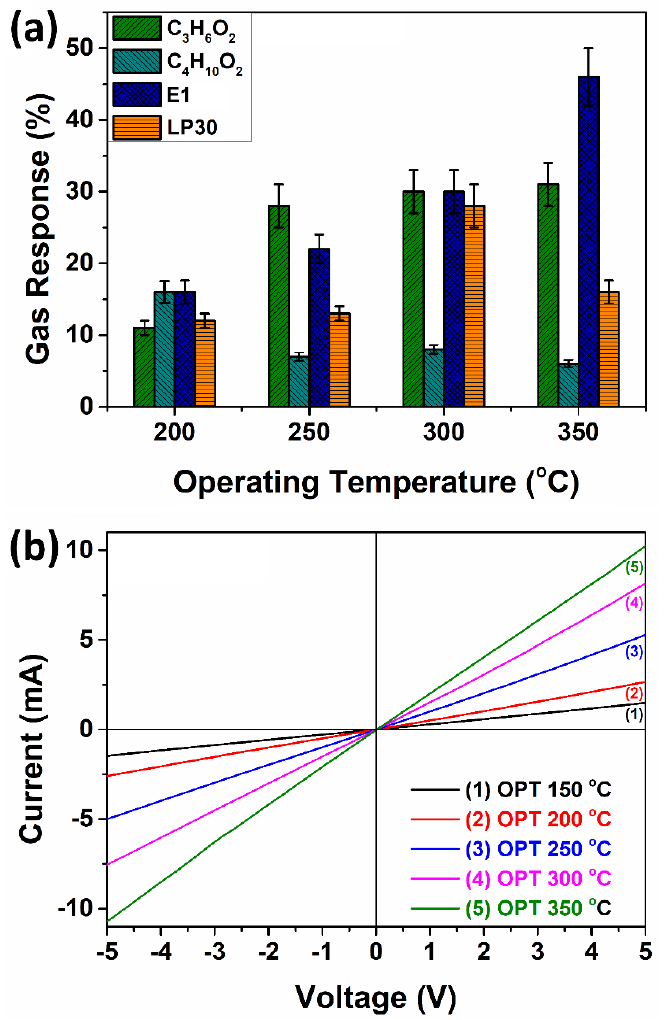
Figure 11. ( a ) Gas response to vapors (concentration 100 ppm) in dependence of operating tem- perature for the 3D printed copper and iron oxide sensors; ( b ) I/V-curves for various operating temperatures for 3D printed copper and iron oxide based